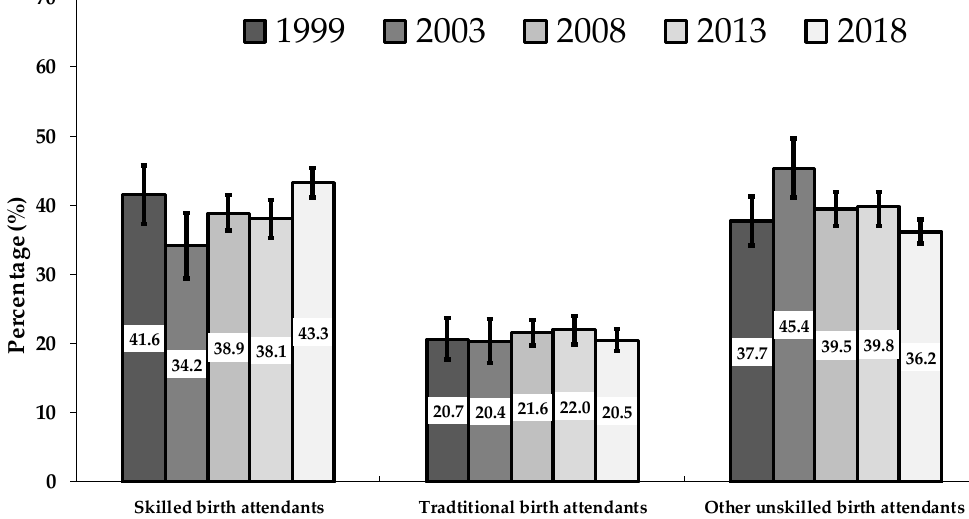
Figure2. TrendsindeliveryassistanceinNigeria, 1999–2018. Figure 2. Trends in delivery assistance in Nigeria, 1999–2018. Error bars indicate 95% confidence interval.